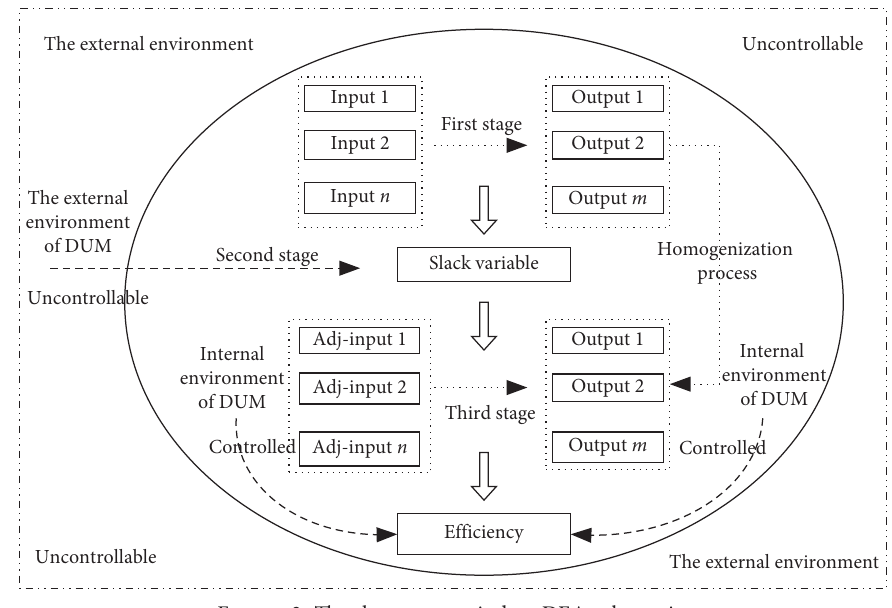
Figure 2: The three-stage window DEA